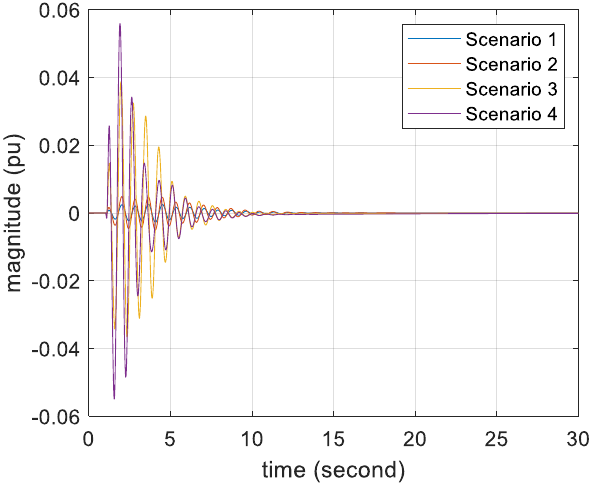
Figure 14. D-axis current responses of BESS.